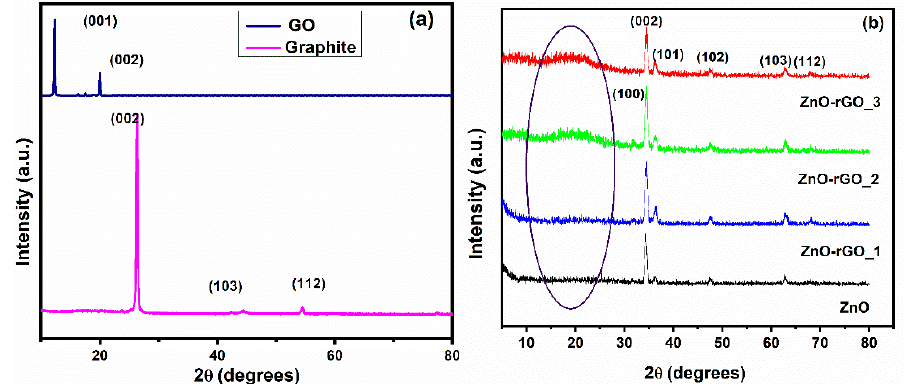
Figure 1. X-ray diffraction patterns. ( a ) Graphite and graphene oxide in powder and ( b ) ZnO and ZnO-rGO thin films. Table 1. Structural parameters of ZnO and ZnO-rGO thin films.